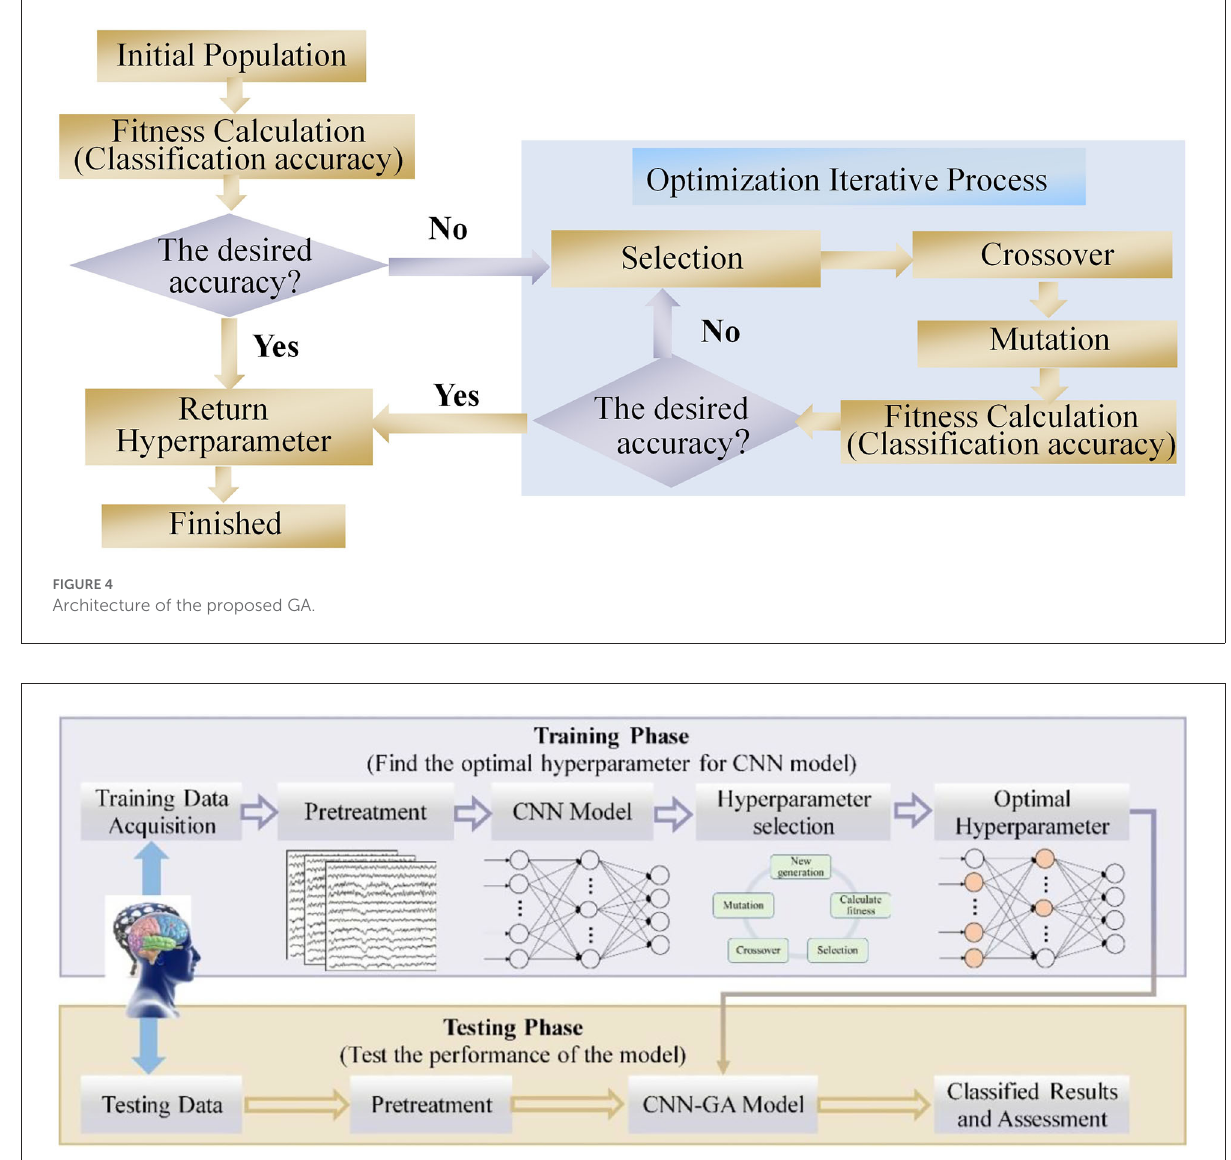
FIGURE5 Scheme of the proposed CNN–GA algorithm.